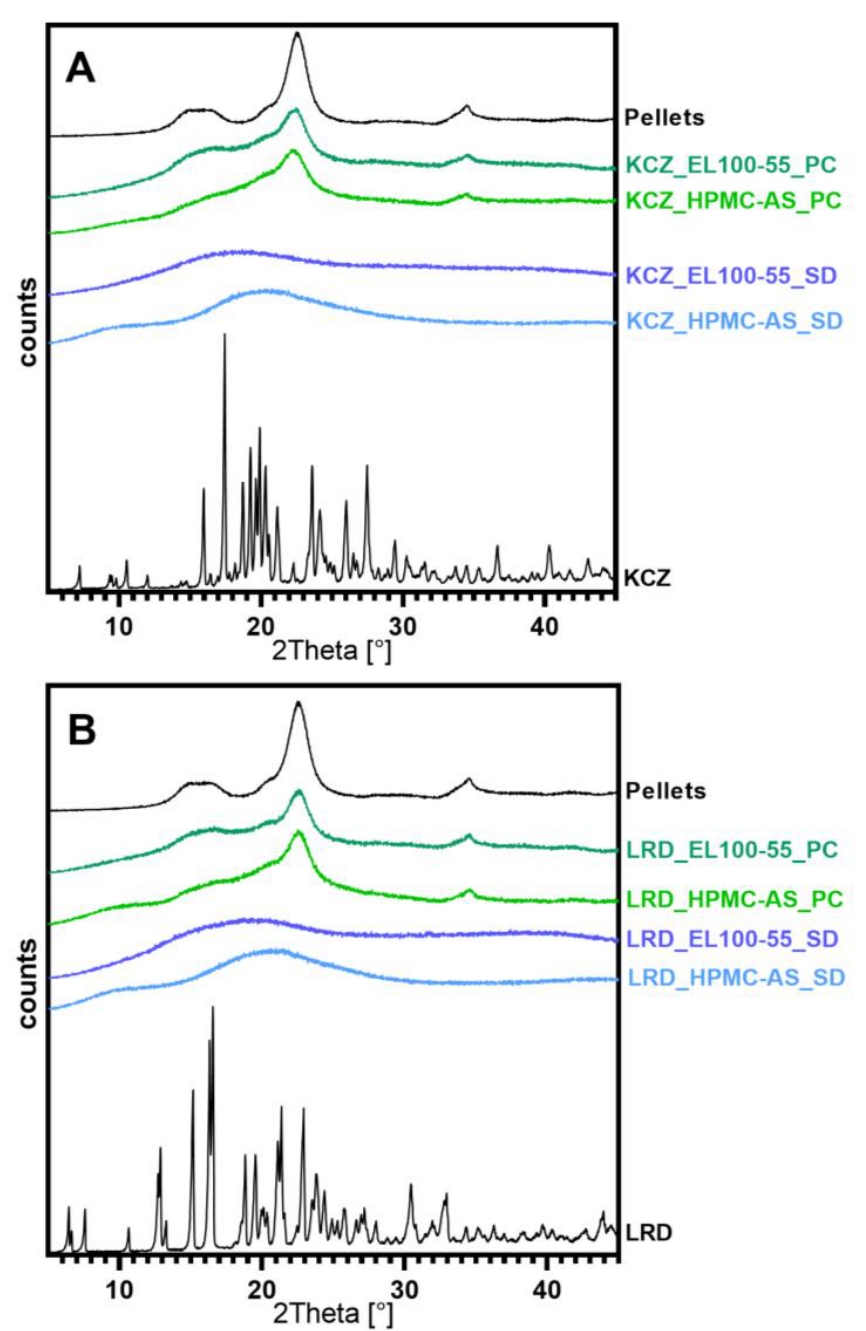
Figure 4. XRD-results of all prepared samples and pure API and pure Pellets (black lines), ( A ) Ketoconazole and ( B ) Loratadine (light blue line: HPMC-AS_SD; dark blue line: EL100-55_SD; light green line: HPMC-AS_PC; dark green line: EL100-55_PC).